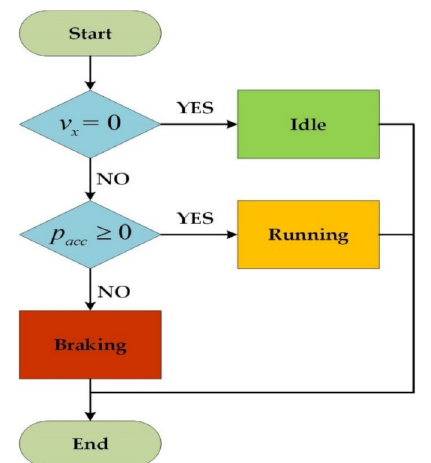
Figure 7. Flowchart of rule-based control strategy in vehicle operation mode.